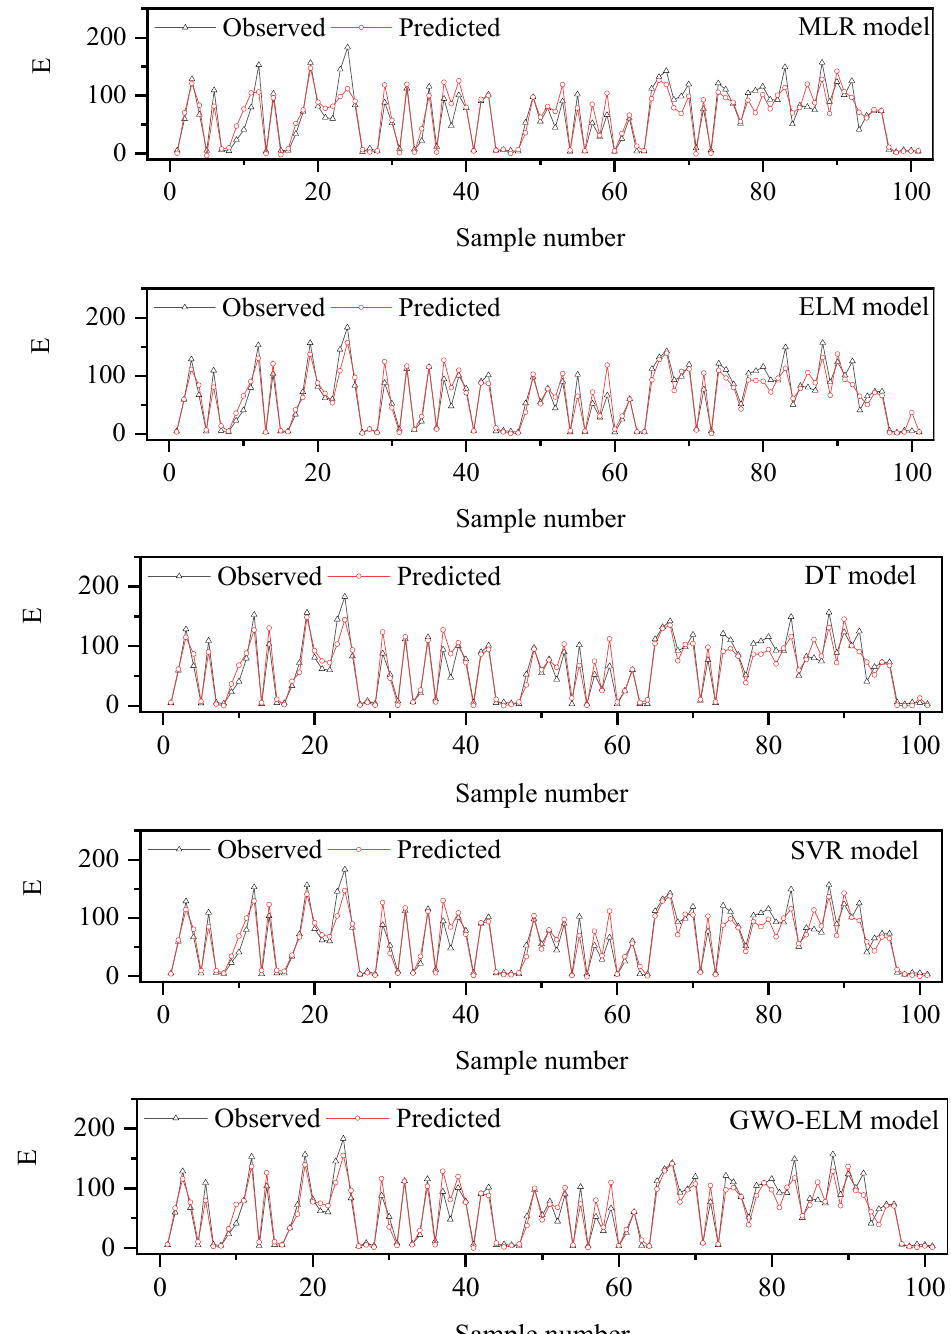
Figure 10. Comparison between prediction results and actual values of different models for E.